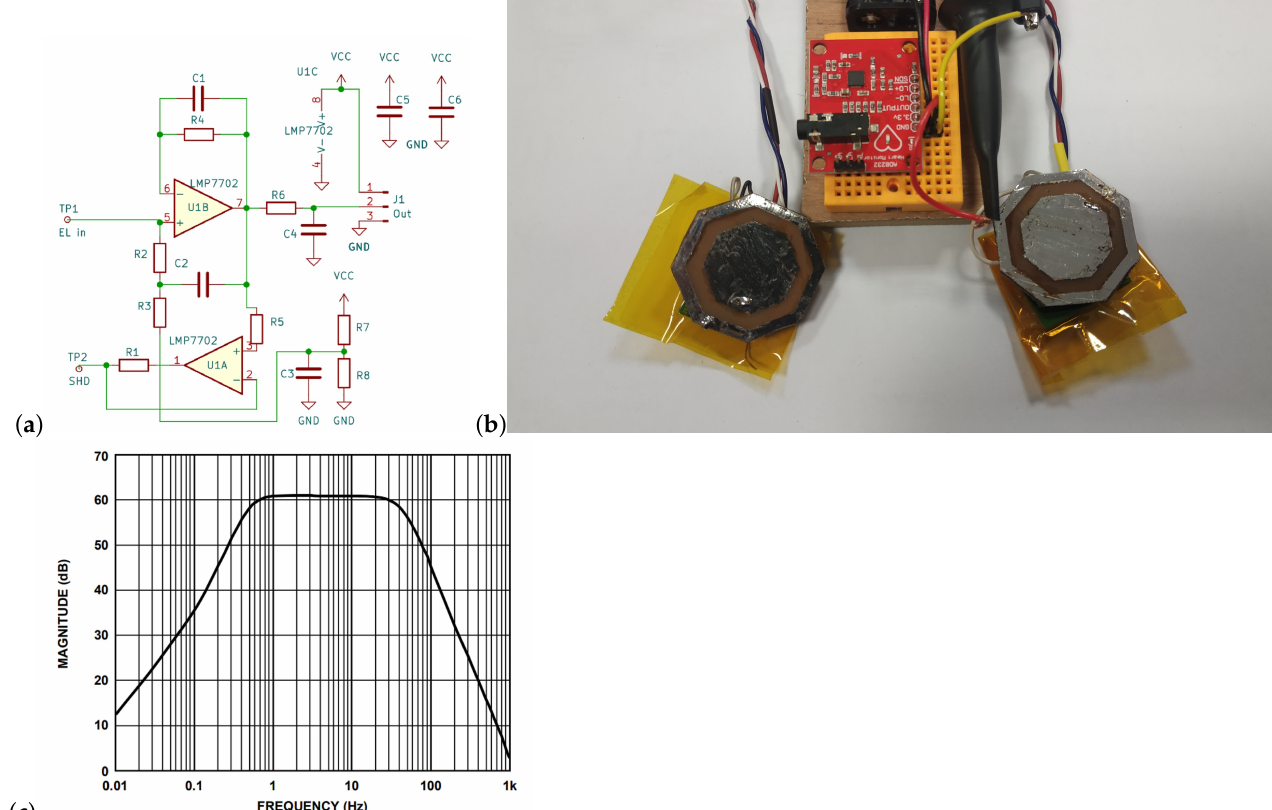
Figure 6. Developed capacitive electrode: ( a ) circuit diagram, ( b ) measurement system (DRL electrode not shown), ( c ) frequency characteristic of the measurement system as determined by an